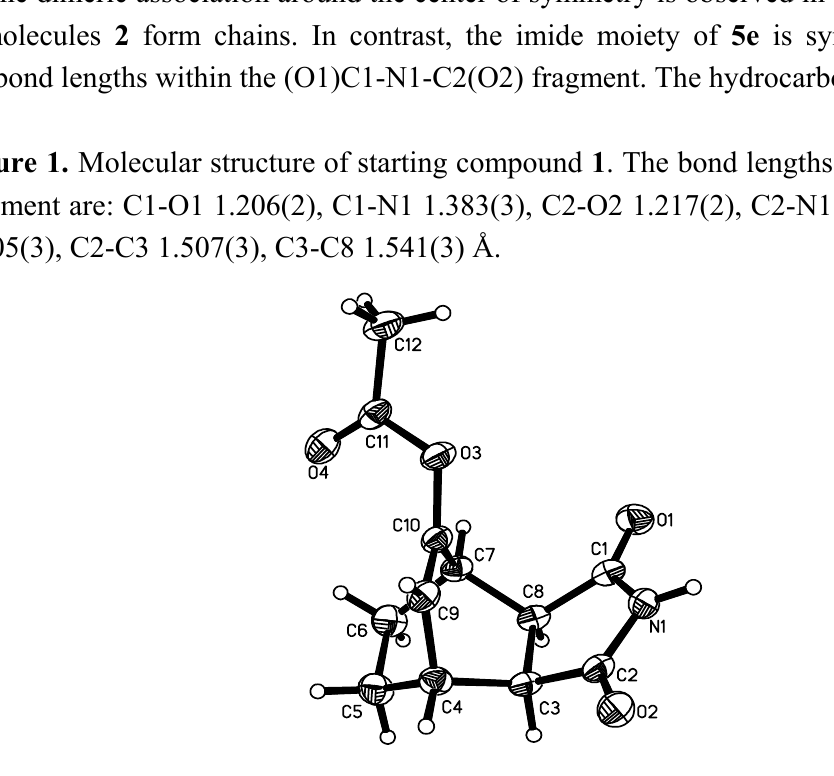
Figure 2. Molecular structure of starting compound 2 . The bond lengths within the imide fragment are: C1-O1 1.216(2), N1-C1 1.367(2), C2-O2 1.206(2), C2-N1 1.386(2), C2-C3 1.508(2), C1-C8 1.511(2), C8-C3 1.540(2)